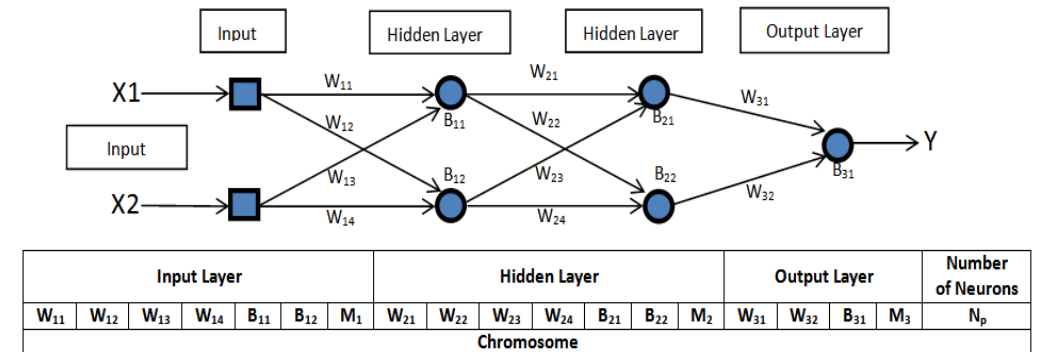
Figure 6. Codification of a Neural Network.